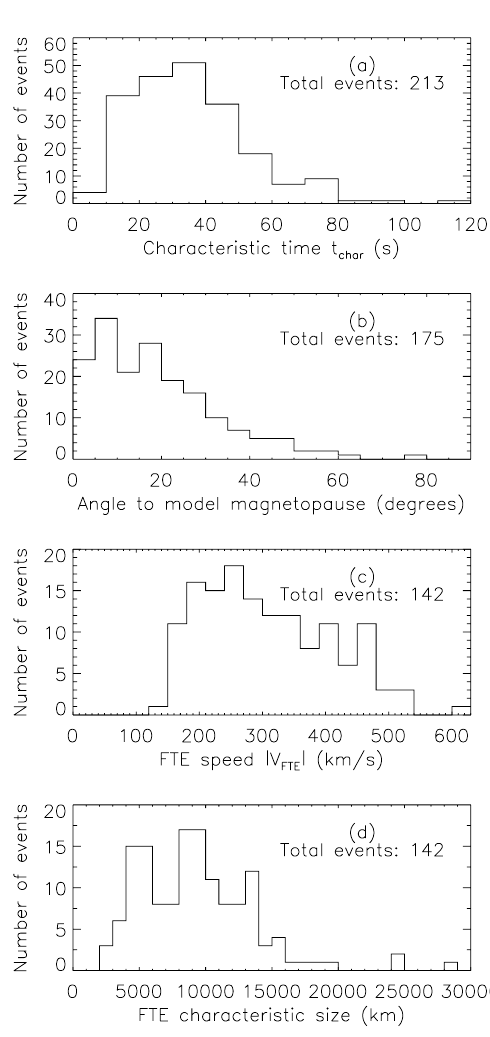
Fig. 6. Histograms of various properties of the FTEs observed by all four spacecraft. (a) The characteristic time ( t char ) for each of the FTEs observed by all four spacecraft. (b) The angle between the model FTE velocity V FTE and the Cooling model magnetopause surface, for each of the FTEs observed by all four spacecraft and where the angular uncertainty on V FTE was less than 30 ◦ . (c) The speed of each FTE which had a velocity deduced to an angular un- certainty of less than 30 ◦ , and where the FTE velocity was within 30 ◦ of the Cooling model magnetopause surface. (d) The charac- teristic size ( | V FTE |× t char ) for each of the FTEs in